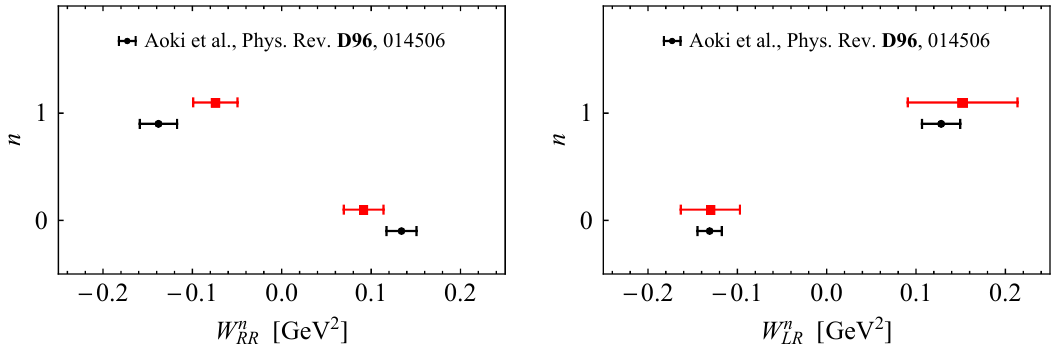
Figure 6 . Comparison between the physical form factors W n our LCSRs (red squares and error bars) and the state-of-the-art LQCD calculation (black dots and error bars) [39]. The shown results correspond to the MS scheme renormalised at 2 GeV . See main text for additional